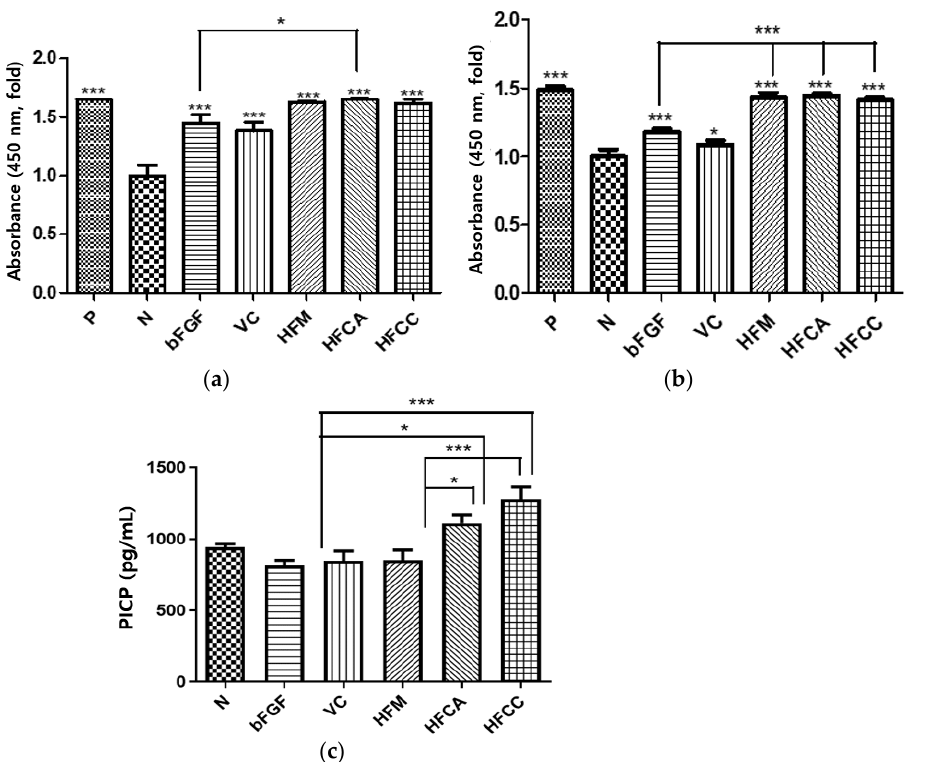
Figure 7. In vitro activity assay of HWGA ‐ SA bFGF coacervates at 5 days ( n = 3). ( a ) HDF viability assay under normal conditions and ( b ) hyperglycemic conditions, and ( c ) PICP ELISA assay under hyperglycemic conditions. *** p < 0.001, * p < 0.01.